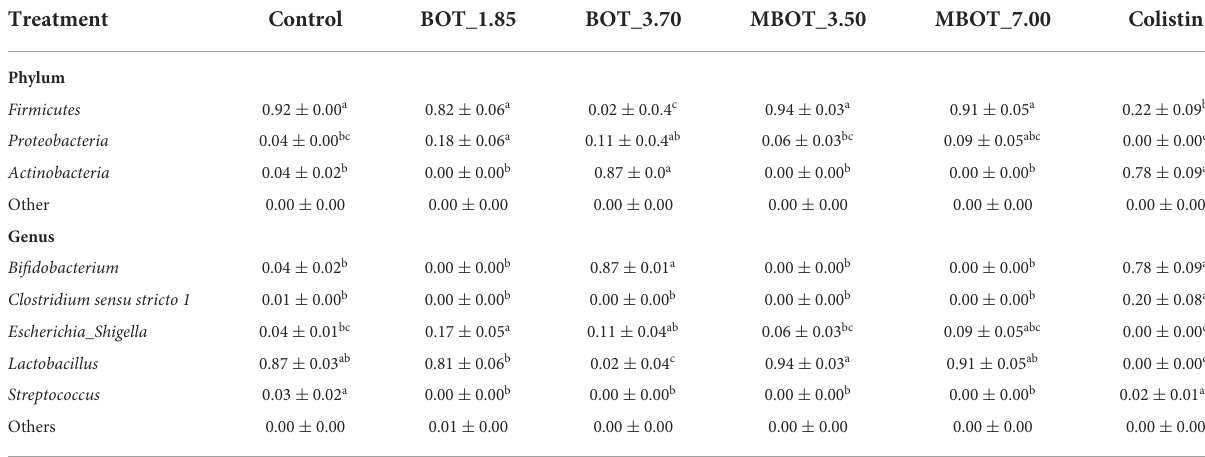
TABLE 3 Relative abundance * of phyla and genera after 72h of ileal microbiota fermentation as the effect of BOT oil treatment, both unprotected (BOT) and microencapsulated (MBOT). Treatment